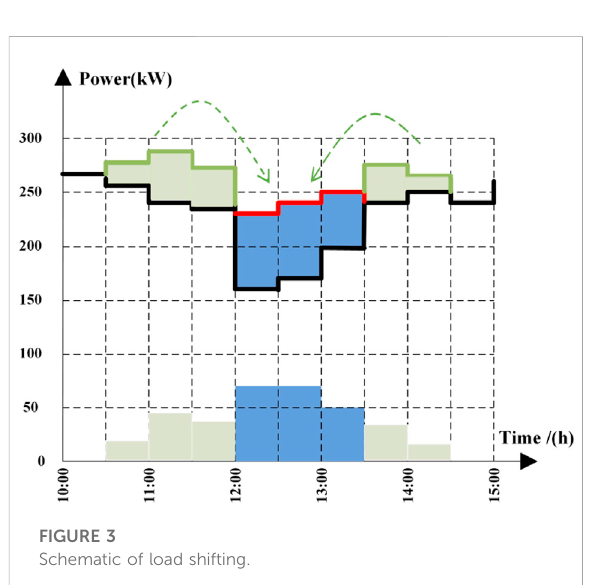
FIGURE 3 Schematic of load